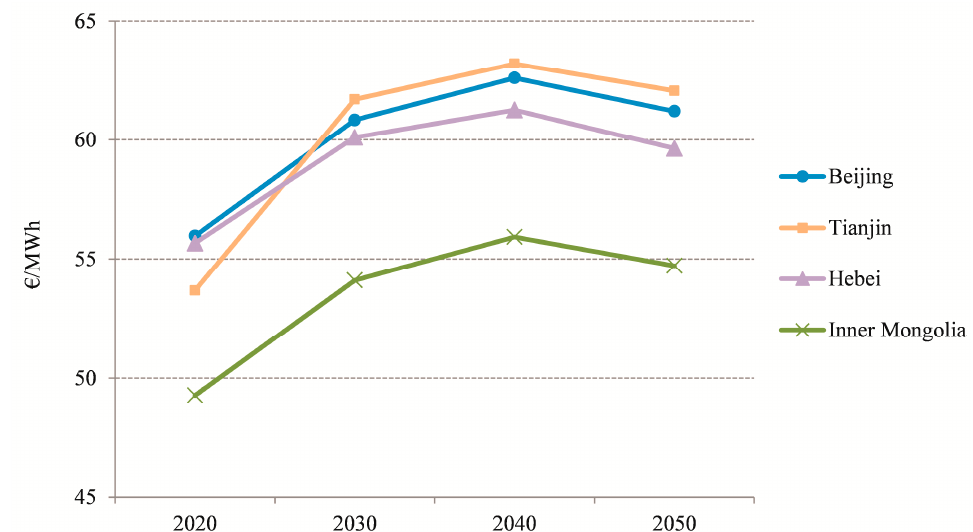
Figure 6. Mean marginal electricity costs over the optimization period by model region.